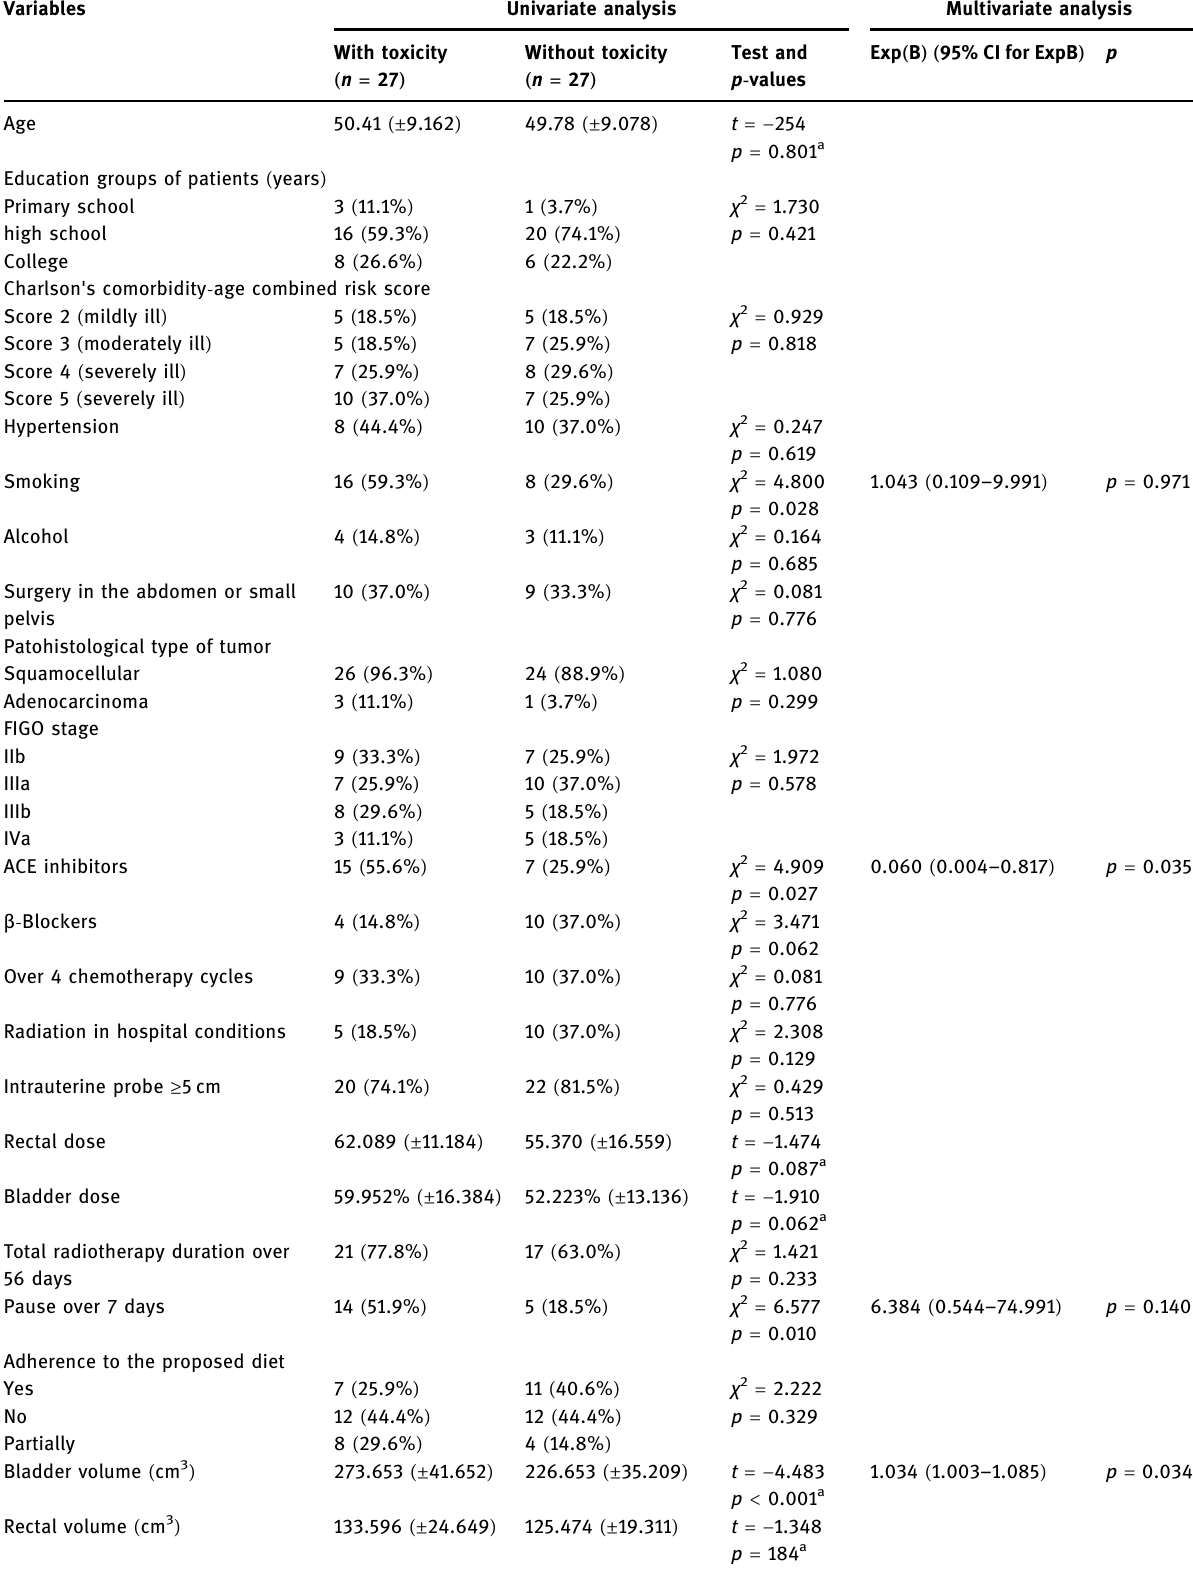
Table 1: Analysis of potential risk factors important for ART onset in patient treated with 3D -